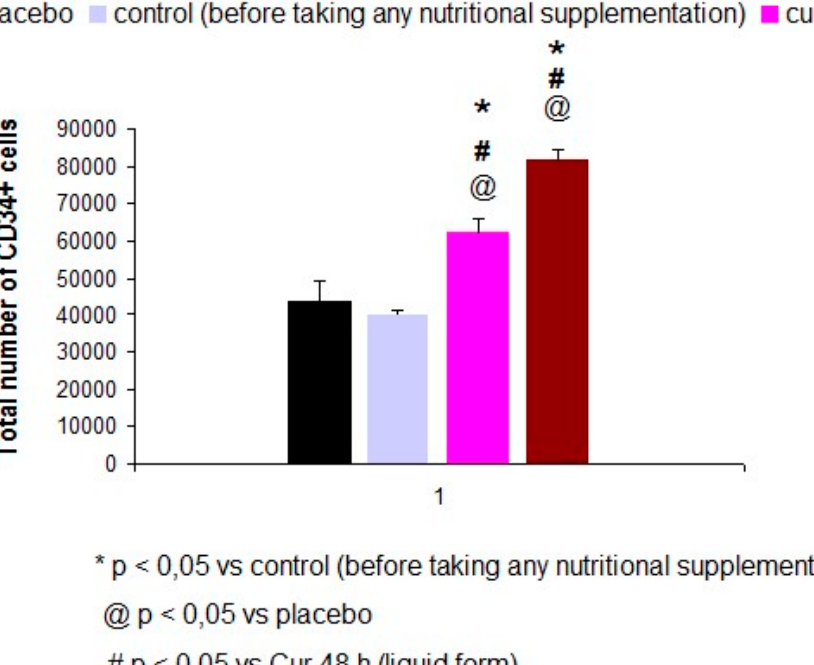
Figure 5. Enhanced HSC mobilization by long-term nutritional supplementation with curcumine curcumin, glycosinolate of sulforaphane in healthy subjects. Placebo ( n = 7): treated-subject with the excipient. They did not consume active principles from plants.